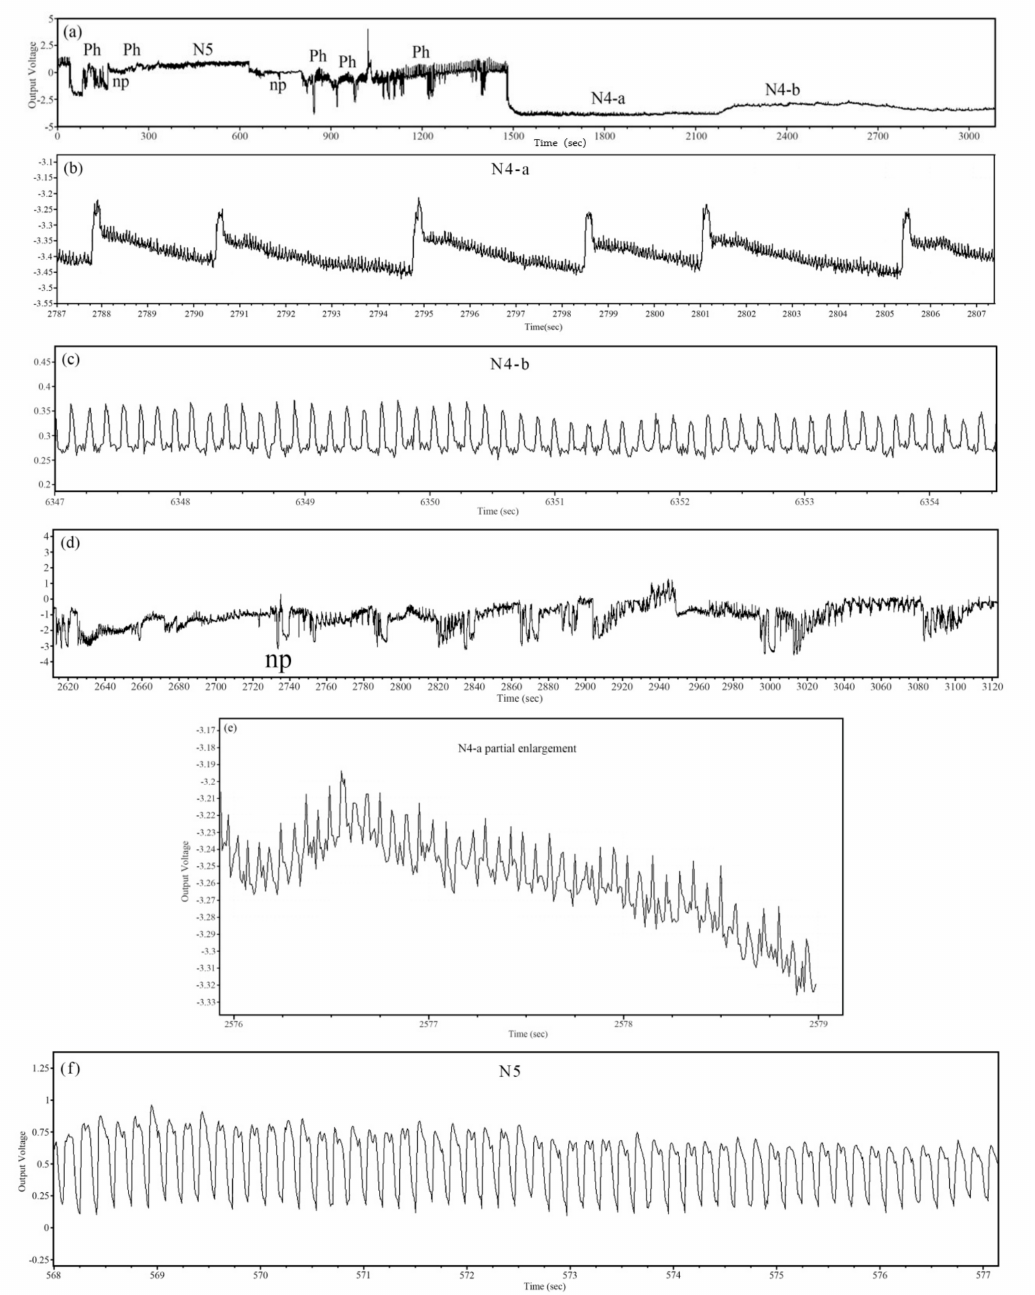
Figure 3. Analysis of EPG waveform characteristics of BPHs aspiration behavior. Integrity waveforms of 6 h EPG identified from BPH ( a ), local amplification feature of N4-a ( b ), N4-b (an intracellular activity of the scalpel within the phloem) ( c ), in detail for np (nonpenetration) ( d ), partial enlarged detail of N4-a (sustained phloem sap ingestion in the phloem tissue) ( e ), N5 (stylets in the xylem tissue termed putative xylem ingestion phase) ( f